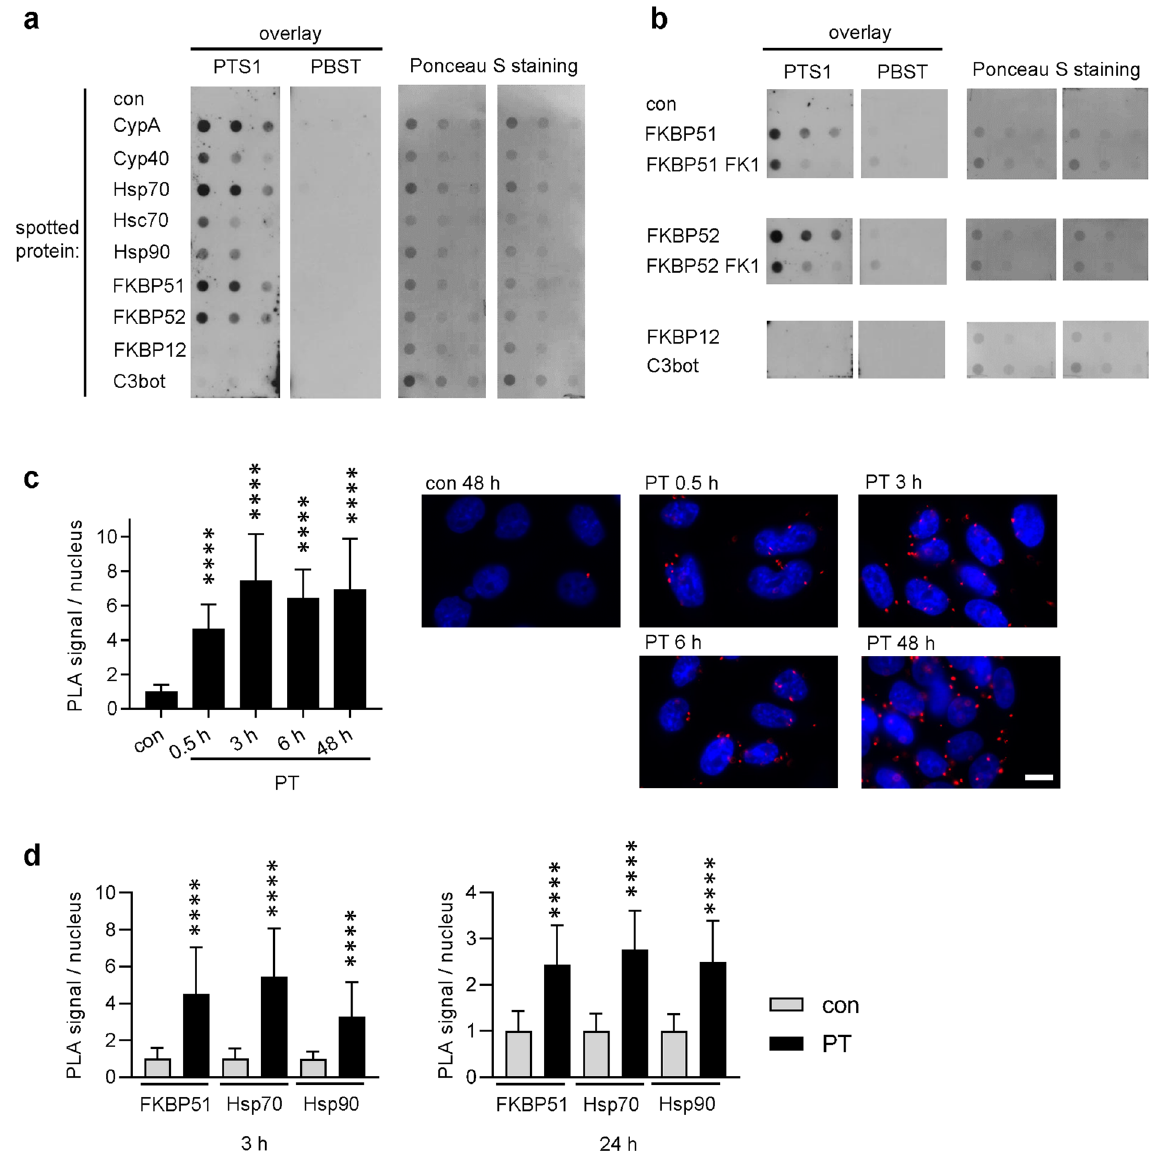
Figure 4. ( a ) PTS1 interacts with chaperones and PPIases in vitro. Purified chaperones/PPIases were spotted two times onto a nitrocellulose membrane in decreasing concentrations (1 µg, 0.5 µg, 0.25 µg). PBS and C3 toxin from C. botulinum were used as negative controls. Membrane was cut and overlay with His-PTS1 (200 ng/ml) or PBST was performed. After extensive washing, bound PTS1 was detected with a specific antibody. PTS1- and PBST-overlayed membranes were detected on the same X-ray film and images were cropped for display purposes only. Comparable amounts of spotted protein were confirmed by Ponceau S-staining. ( b ) PTS1 binds to the isolated PPIase domains of FKBP51/52. FKBP51/52 and their FK1 fragments i.e. isolated PPIase domains were spotted onto a nitrocellulose membrane. The experiment was further conducted as described in A. All signals were detected on the same X-ray film and images were cropped for display purposes only. ( c ) Cyp40 interacts with PTS1 in cells. CHO-K1 cells were incubated on ice with PT (5 µg/ml) for 30 min to enable binding or left untreated for control. After washing, the cells were further incubated for 0.5 h, 3 h, 6 h and 48 h at 37 °C. Cells were fixed and fluorescence-based PLA assay was performed according to the manufacturer’s manual. PLA signals represent one protein interaction event of PTS1 and Cyp40 and were counted from fluorescence pictures (n = 10 pictures per condition, mean ± SD) with ImageJ. Values were normalized to the mean of the control samples. Significance was tested by one-way ANOVA with Dunnett’s multiple comparisons test and refers to untreated control samples (****p < 0.0001). One representative image is shown for each condition (blue = nucleus, red = PLA signal). Scale bar = 10 µm. ( d ) FKBP51, Hsp70 and Hsp90 interact with PTS1 in cells. CHO-K1 cells were treated with PT (3 µg/ml) for 3 h (left) or 24 h (right) at 37 °C. Then, cells were fixed, and fluorescence-based PLA assay was performed according to the manufacturer’s manual. PLA signals were counted from fluorescence pictures (n = 20 images per condition from at least 2 independent experiments, mean ± SD) with ImageJ. Values were normalized to the mean of the control samples. Significance was tested by Mann–Whitney test and refers to the respective untreated controls (****p <